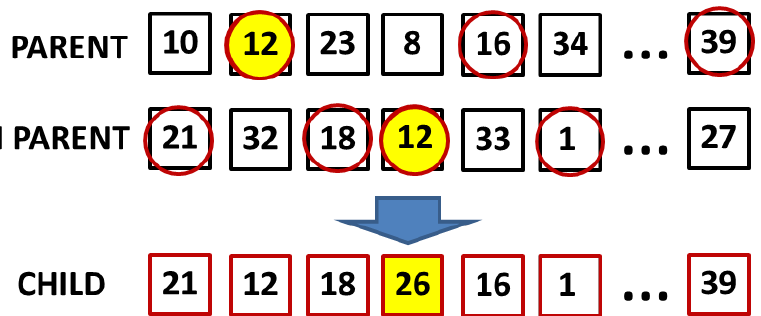
Figure 5. Depicting crossover and mutation operations within a genetic algorithm [17].